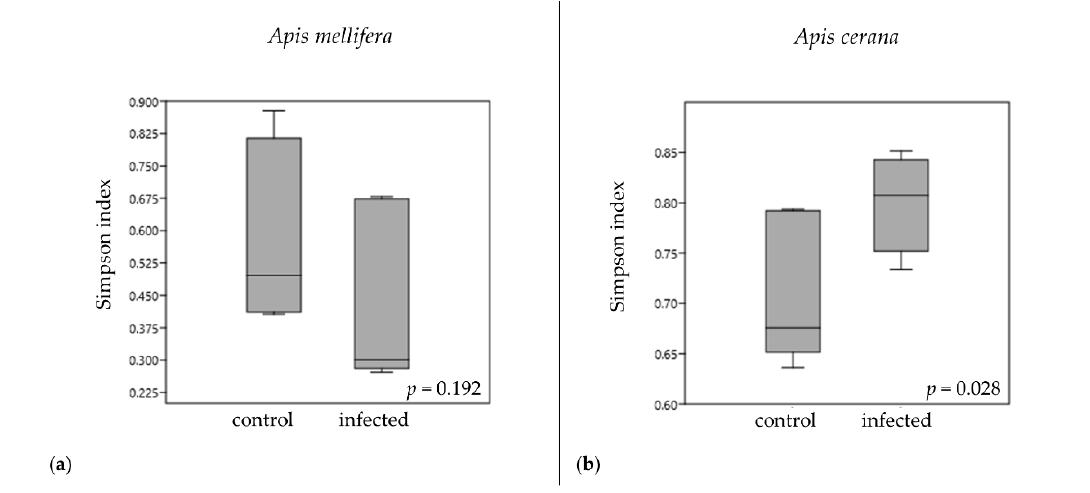
Figure 3. Alpha diversity boxplots compare the larval microbiome between the control and the infected worker larvae of A. mellifera ( a ) and A. cerana ( b ) designated by the Simpson index.